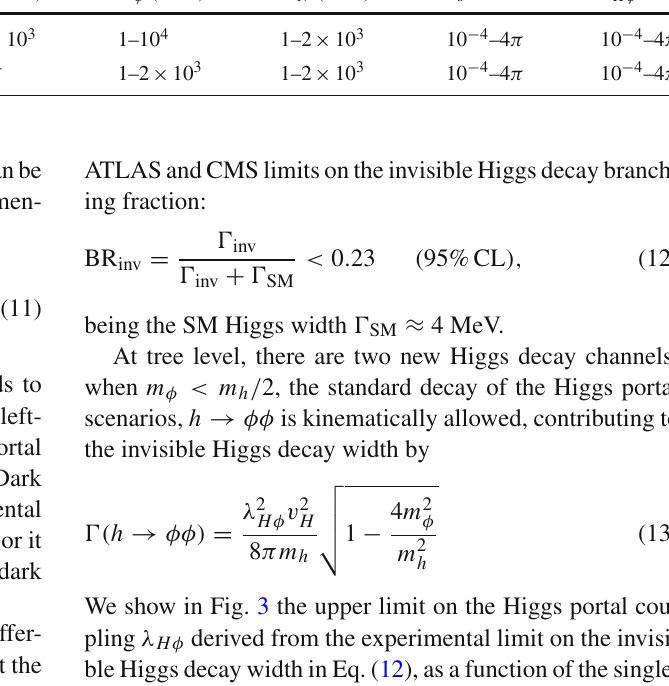
Table 1 Explored parameter space in the models